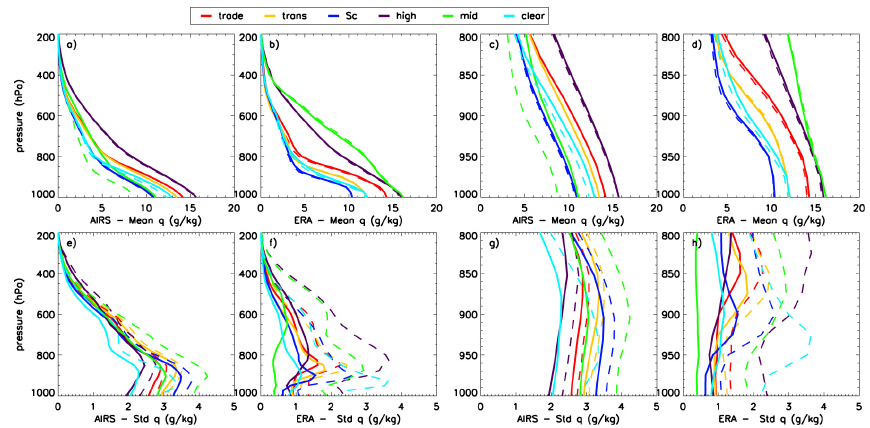
Fig. 7. The same as Fig. 5 except for the vertical profile of water vapor mixing ratio (g/kg).